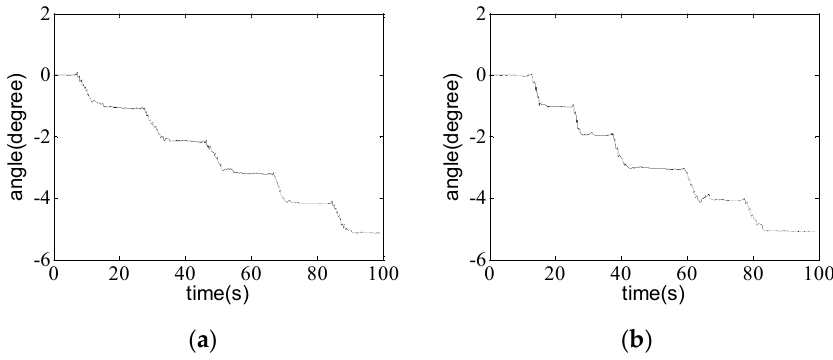
Figure 6. Angle variation with step-by-step method. ( a ) Angle around x -axis; ( b ) Angle around y -axis.